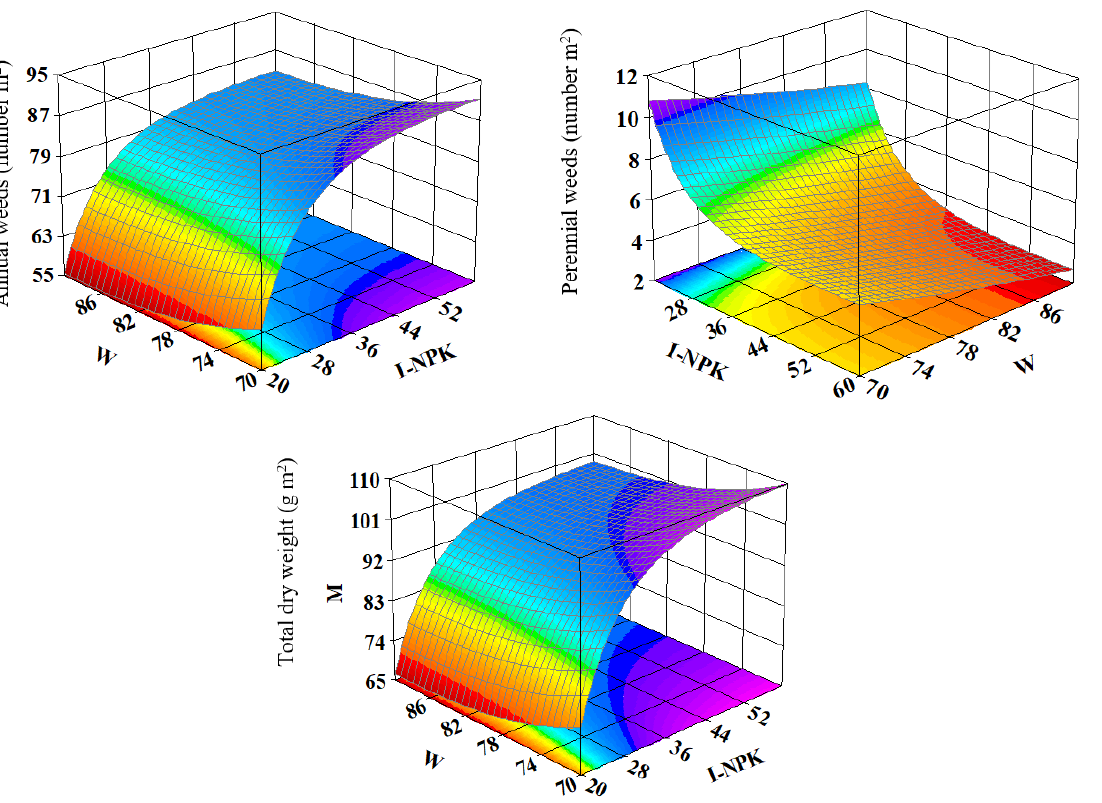
Figure 2. Distribution of annual and perennial weeds, and total dry weight, depending on water supply conditions (W) and soil nutrient availability.